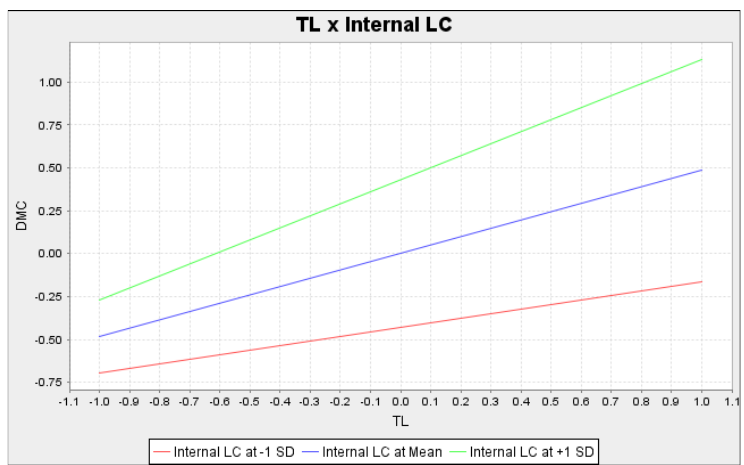
Figure 3: Moderating effect of LC between TL and